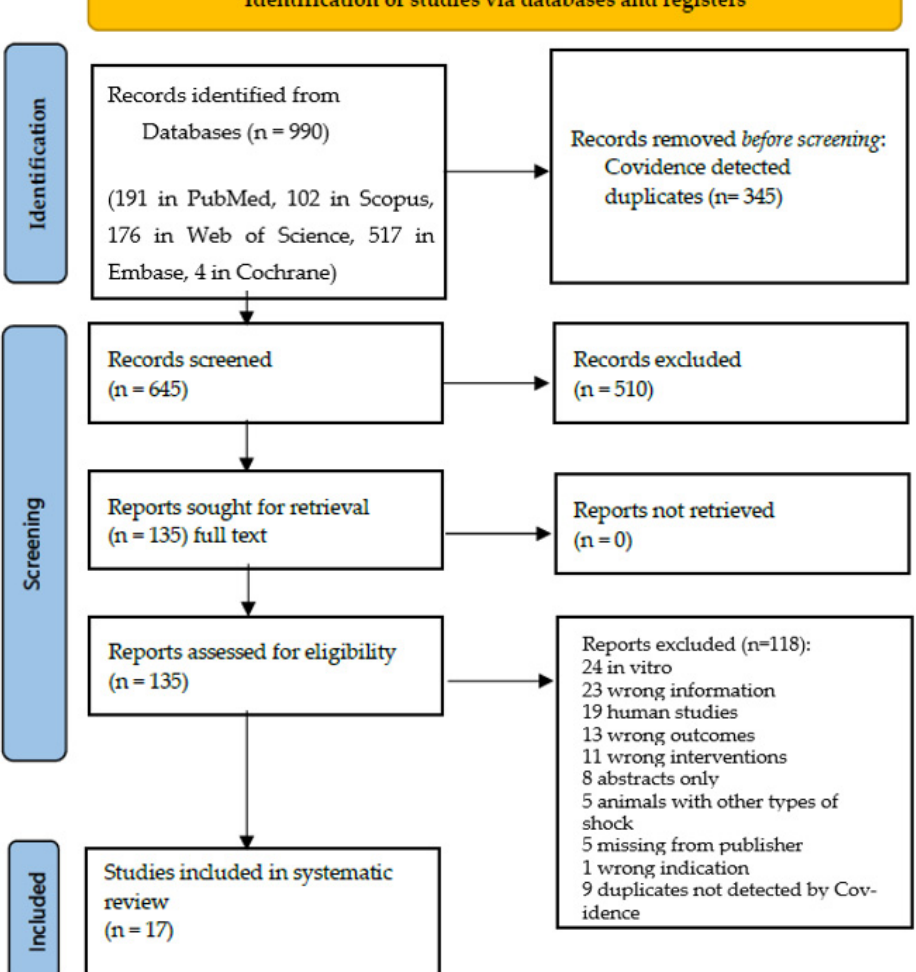
Figure 3. PRISMA 2020 flow diagram [17]. The number of studies identified from databases, screened for eligibility and the final included papers in the systematic review. This flow diagram is